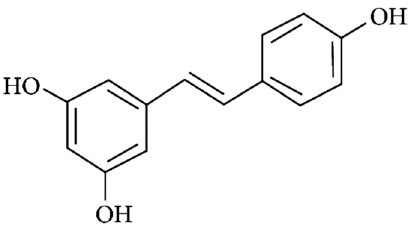
Fig. 4 Structure of resveratrol (3,5,4 ′